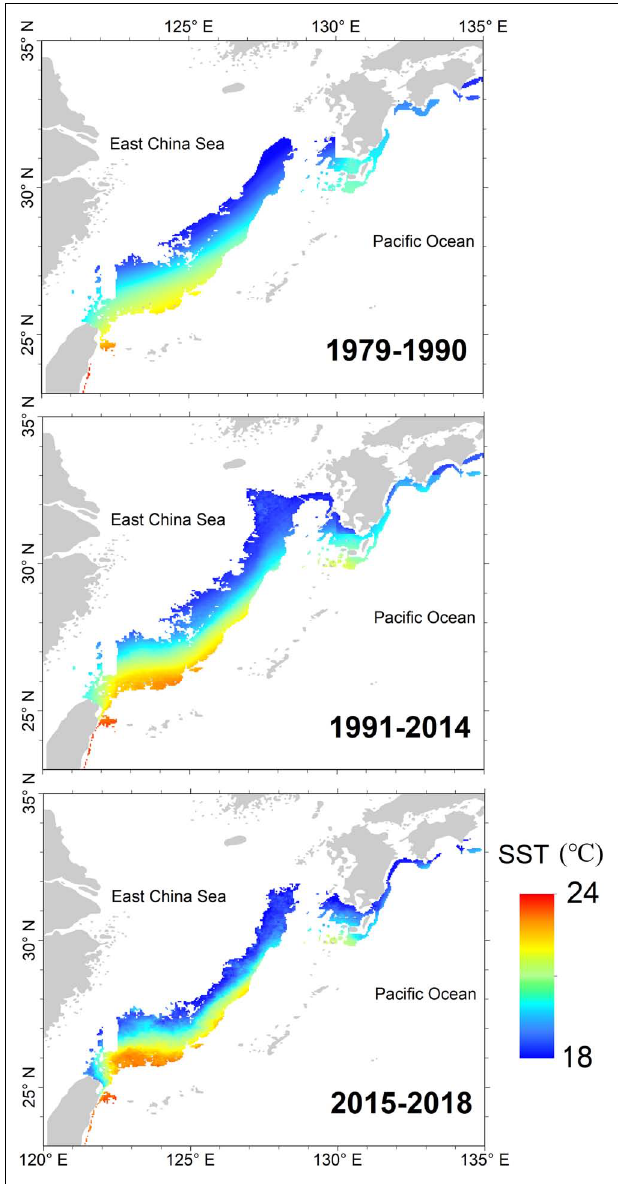
FIGURE 9 | The average potential spawning ground of winter cohort of Japanese flying squid during the three identified regimes: 1979–1990, 1991–2014, and